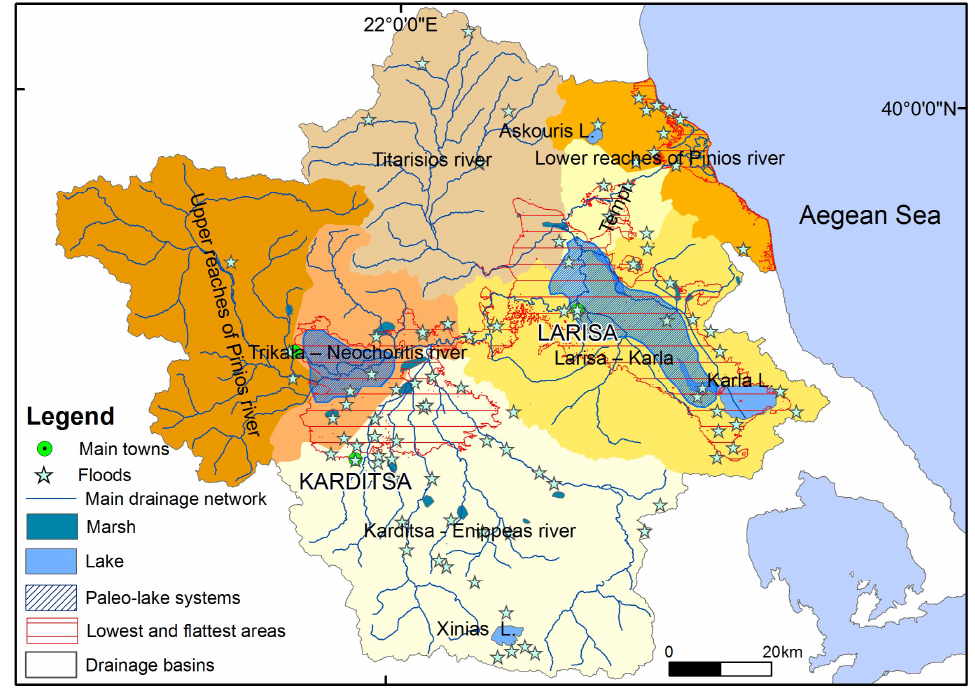
Figure 12. Marshy areas, lakes, paleo-lakes and lowest and flattest areas vs. flood occurrences in each drainage sub-basin of the study area during the period